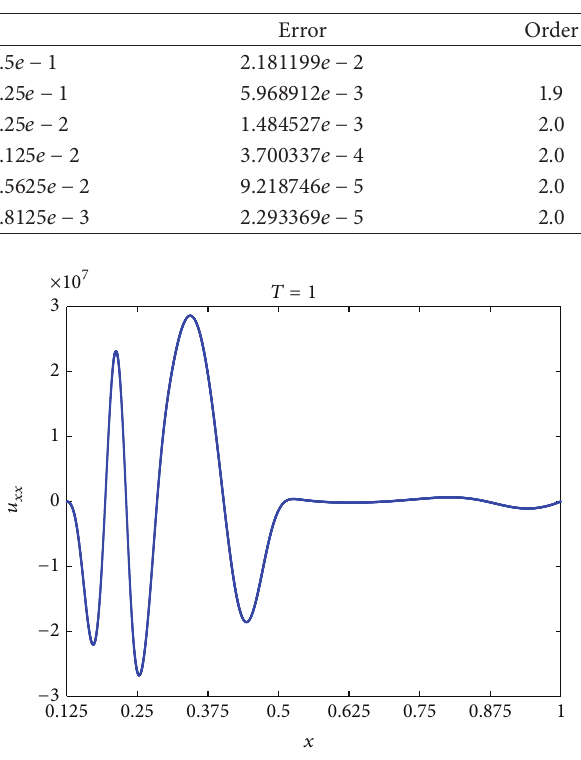
Table 1: Test Problem 1. Error and numerical convergence order. 𝑇 = 1 .